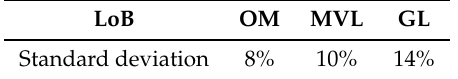
Table 1. Premium Risk Volatility factors for Lines of Business (LoBs)—Delegated Acts, Annex